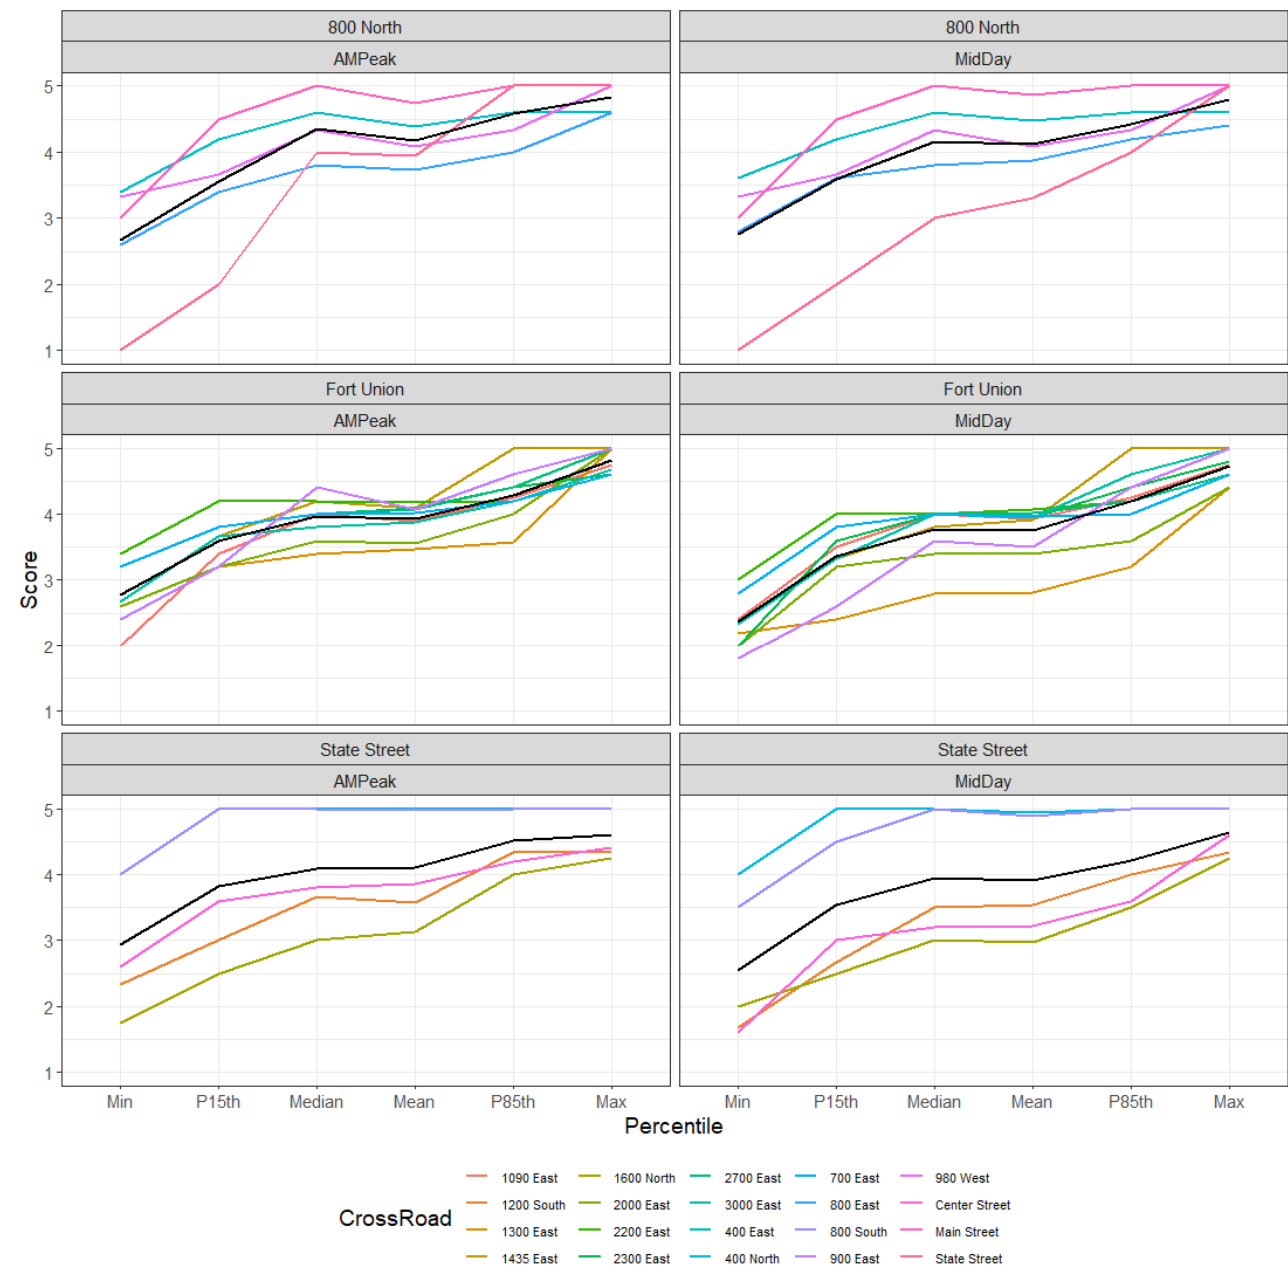
Figure 5. Overall score for the intersection and corridor levels.